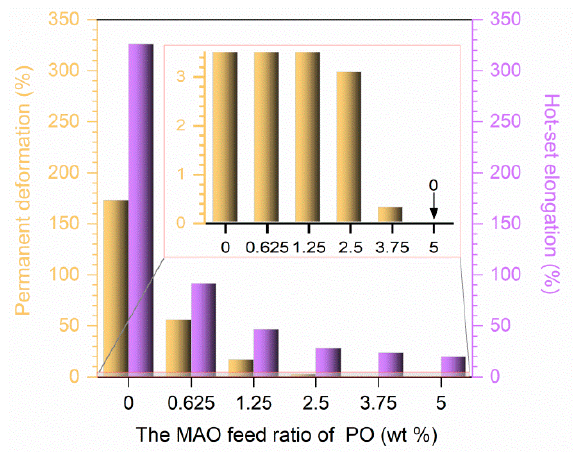
Figure 4. The hot-set elongation and permanent deformation of PPC and PPC–MAO with networks.